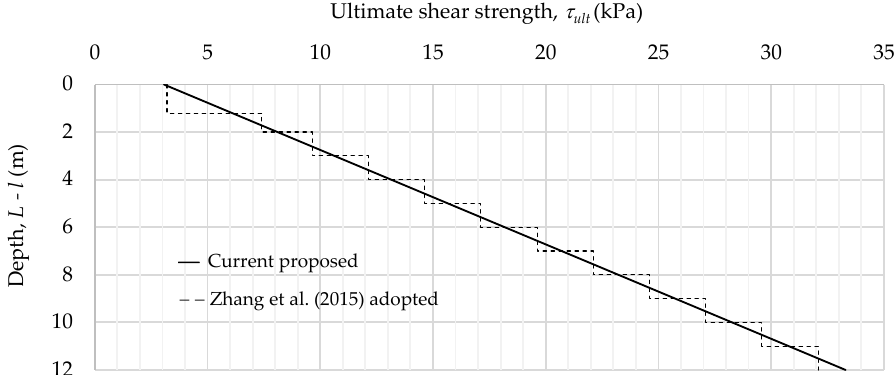
Figure 21. Adopted strength profile of the interface in the proposed analytical and FE models.